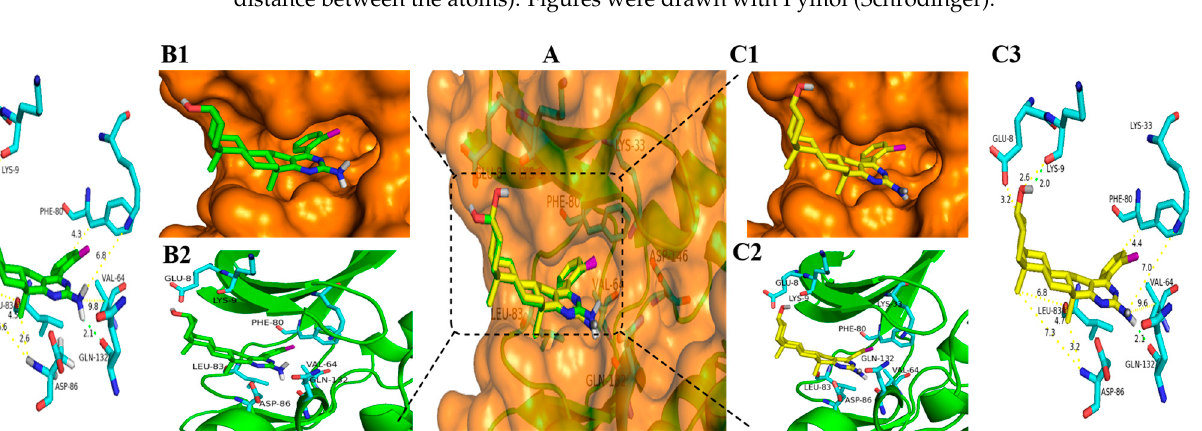
Figure 8. Docking modes of 3l and 6l with CDK1 (PDB code: 6GU6). ( A ) Overview of the binding site of 3l (green stick) and 6l (yellow stick) with CDK1 (orange transparent surface structure fused with a sticks structure of white hydrogen atoms, cyan carbon atoms, blue nitrogen atoms, and red oxygen atoms); ( B1 ) Position of 3l in the orange surface structure of CDK1; ( B2 ) Position of 3l in cartoon structure of CDK1; ( B3 ) Binding model for 3l bond to CDK1 (Hydrogen bonds are drawn as green dashed lines with distances labelled in Å while the yellow dashed lines just display the distance between the atoms); ( C1 ) Position of 6l in the orange surface structure of CDK1; ( C2 ) Posi- tion of 6l in cartoon structure of CDK1; ( C3 ) Binding model for 6l bond to CDK1 (Hydrogen bonds are drawn as green dashed lines with distances labelled in Å while the yellow dashed lines just display the distance between the atoms). Figures were drawn with Pymol (Schrödinger).